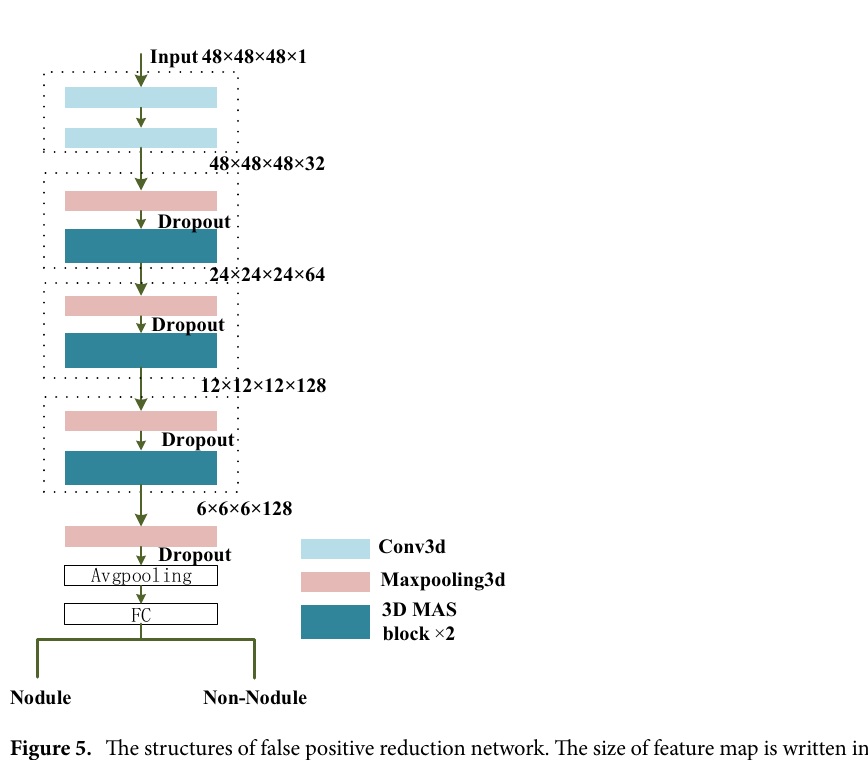
Figure 5. The structures of false positive reduction network. The size of feature map is written in the form of (#length × #width × #height × #channel), such as (48 × 48 × 48 ×